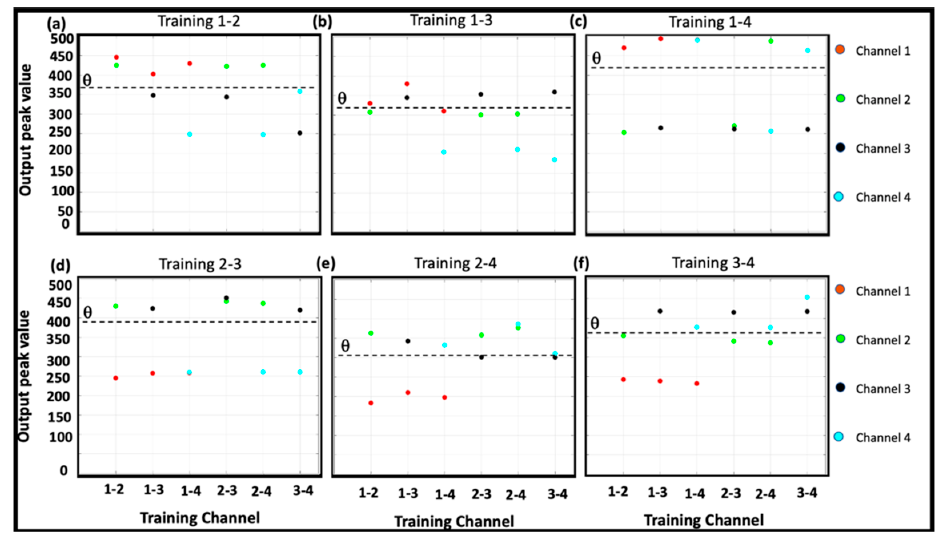
Figure 12. Amplitudes of the output signals for the different training 2-digit, 4-bit numbers. As shown, for each training number, there is only one case in which both outputs exceed the threshold (dashed horizontal line): ( a – f ) report the cases of validation after having trained the possible combinations of channels respectively. However, the network is also able to recognize single-trained digits.